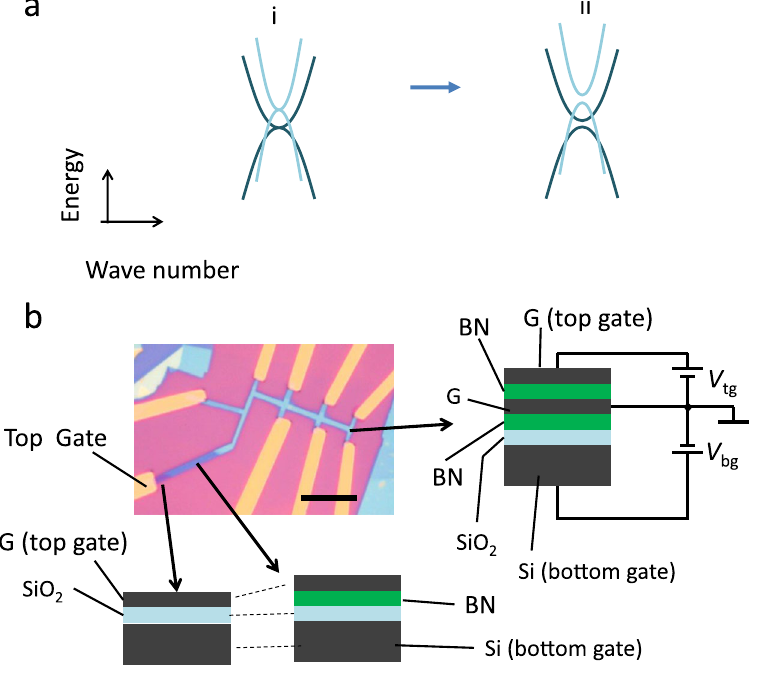
Figure 1. Band structure of tetralayer graphene and sample structure. ( a ) Simplified band structure in tetralayer graphene. i Tetralayer graphene consists of a set of light-mass and heavy-mass bilayer-like bands, which are offset in energy. ii Perpendicular electric field opens a band gap at the bottoms of the conduction and the valence bands. ( b ) Optical micrograph of encapsulated tetralayer graphene sample that has a top gate (Top left). The scale bar is 10 μ m. Schematic structure of an encapsulated graphene stack is shown in the right panel. G is graphene, BN is h -BN, Si is Si substrate and SiO 2 is SiO 2 covering on the Si substrate. Tetralayer graphene was encapsulated with thin h -BN flakes, and it was formed on a SiO 2 /Si substrate. Several layer graphene, which served as a top gate, was deposited onto the top of the encapsulated graphene. Samples were ion-etched into Hall bar shape. Electric contact to the tetralayer graphene was formed by using the technique in ref. 15 . The lead that is indicated by “Top Gate” in the figure is connected to only the top gate graphene by using the structures illustrated by the two figures at the